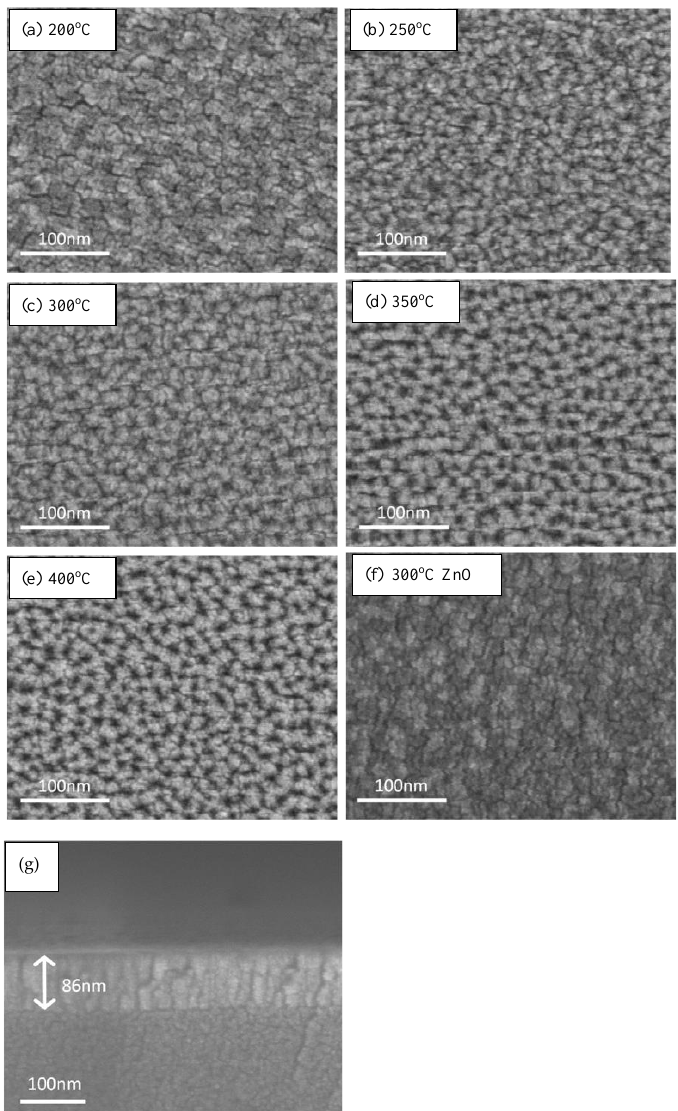
Figure 5. SEM images of 1.0 wt.% WZO films deposited at: ( a ) 200 °C, ( b ) 250 °C, ( c ) 300 °C, ( d ) 350 °C, and ( e ) 400 °C. ( f ) Pure ZnO film deposited at 300 °C. ( g ) Cross-sectional view of 1.0 wt.% WZO film deposited at 300 °C.